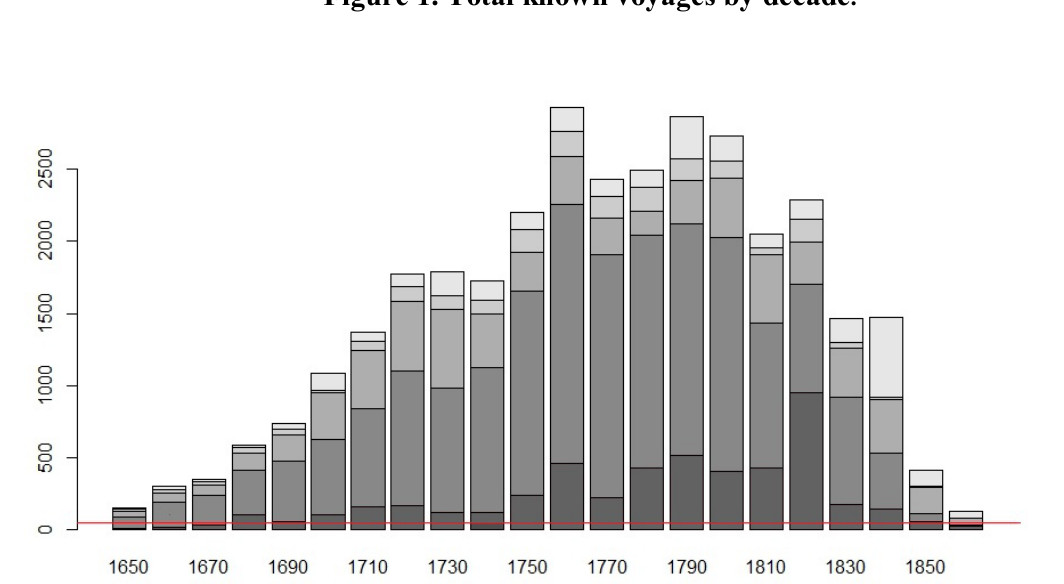
Figure 1. Total known voyages by decade .